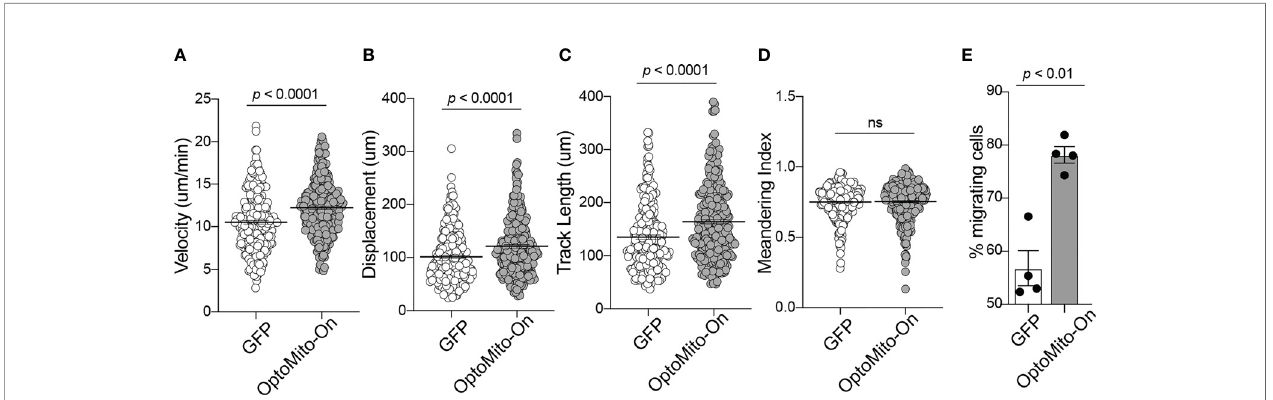
FIGURE 5 | Activation of OptoMito-On increases CD8 + T cell migration. The velocity (A) , displacement (B) , track length (C) , meandering index (D) , and percent migrating cells (E) of Mock (or GFP) and OptoMito-On expressing Day 4 CD8 + T cells migrating on ICAM-1 + CXCL12. The percentage of migrating cells was calculated as the number of cells migrating 5-20 µm/min divided by the total number of cells in the fi eld of view during the 20-minute movie. All movies received 500 nm illumination and were analyzed with Volocity software. All data shown as mean ± SEM and analyzed by a two-tailed unpaired t-test with Welch ’ s correction ( A – D : includes four independent experiments, Mock: 271 cells, OptoMito-On: 312 cells; E : n = 4 movies on the same day). ns, not signi fi